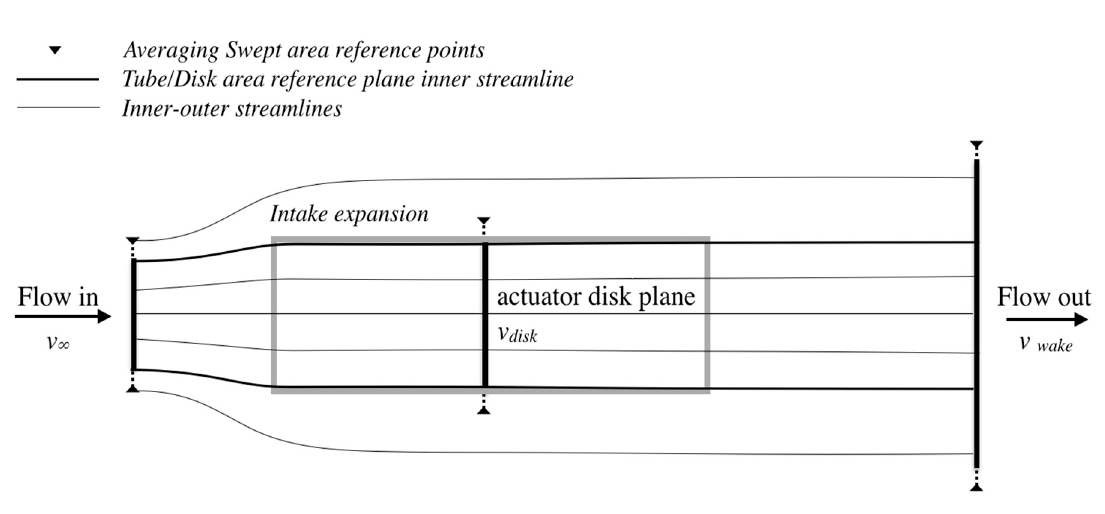
Figure 5. Streamlines around actuator disk inside of a tube.